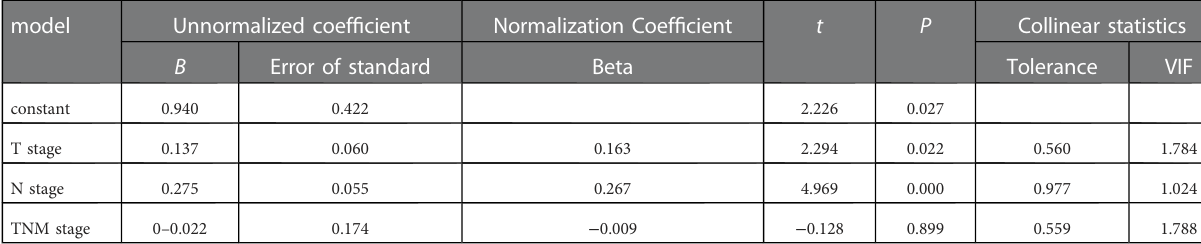
TABLE 3 Results of logistic binary regression analysis of factors affecting NSM. Indicator